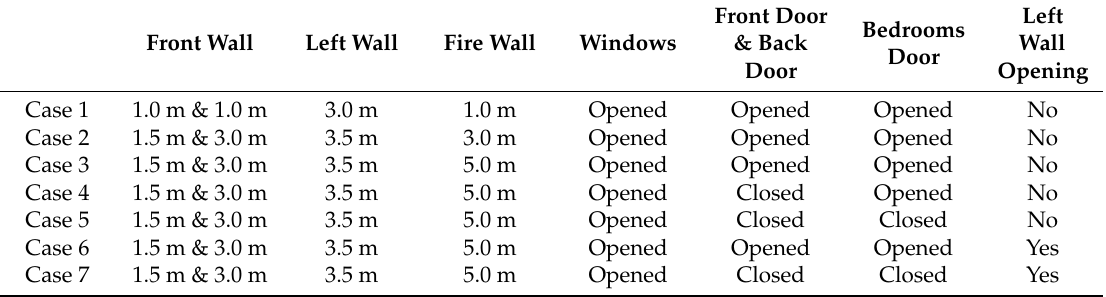
Table 1. Simulation cases for the detached family house (See Figure 2 for walls location).